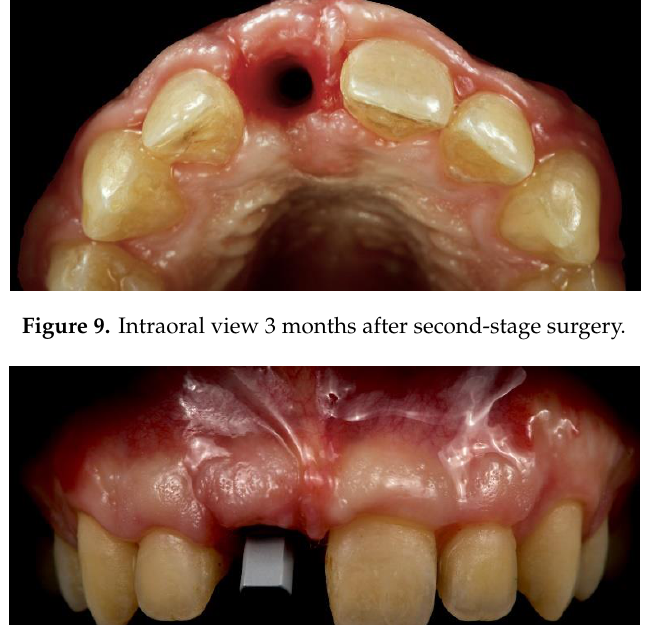
Figure 8. Second-stage surgery: titanium mesh removal and soft-tissue management.